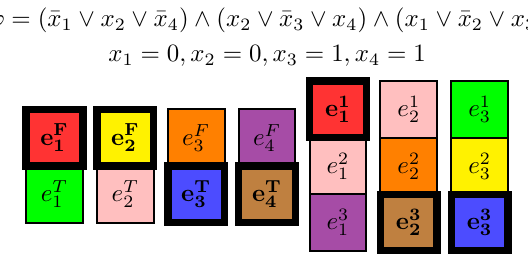
Figure 7 Illustration of the reduction from 3-SAT. Above there is an example of a 3-SAT formula with a feasible assignment. Below we show the instance of the robust representative selection problem corresponding to this instance. Each column corresponds to a partition from which one of the two elements must be selected. The colors correspond to the regions of the instance. The bold elements are an optimal solution corresponding to the shown variable assignment. Note that elements in exactly 4 regions (red, yellow, blue, brown), corresponding to the shown feasible variable assignment, are